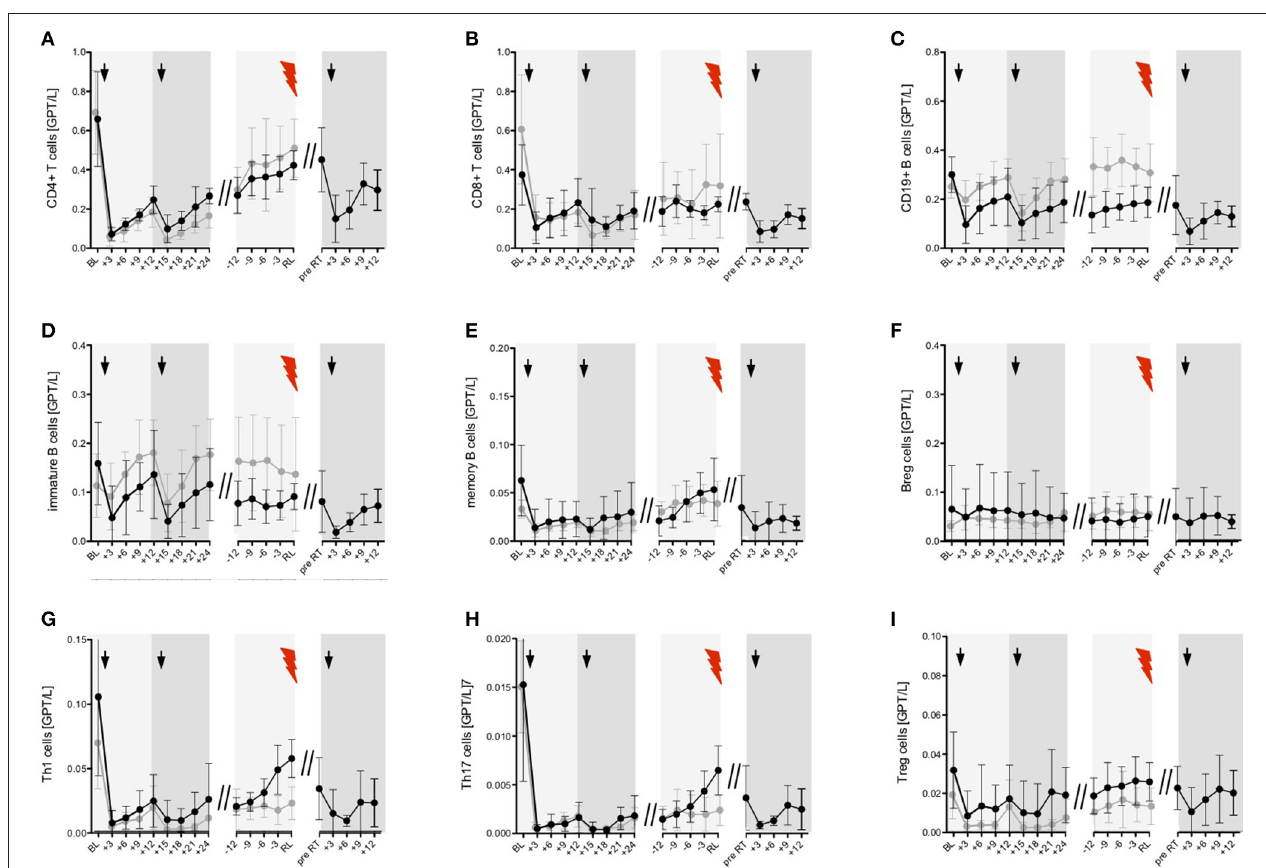
FIGURE 6 | Event-driven immune cell phenotyping before relapse activity and after ATZ retreatment. Distribution of absolute immune cell count of selected T (A,B, G–I) and B cell (C–F) subsets are presented. Black line—partial-responder patients: Immune cell subsets before (baseline, BL) and after 1st and 2nd ATZ infusion 3 monthly up to 24 months follow up ( + 3, + 6, + 9, + 12, + 15, + 18, + 21, + 24) are depicted. Mean values + / − 95%CI of all partial-responder patients are shown. Additionally, distribution of absolute immune cell count before clinical appearance of an acute relapse (RL, red flash) was evaluated in 3 monthly intervals ( − 12, − 9, − 6, − 3). Mean values + / − 95%CI of 13 relapses are presented. Furthermore, absolute immune cell count before ATZ retreatment (pre RT) and during 3 monthly follow up ( + 3, + 6, + 9, + 12) are demonstrated. Mean values + / − 95%CI of 10 ATZ retreatments are shown. Gray line—complete-responder patients: Immune cell subsets before (baseline, BL) and after 1st and 2nd ATZ infusion are depicted. In addition, period of stable disease course 24 months after 2nd ATZ infusion are presented. Mean values + / − 95%CI of all complete-responder patients are shown. Arrows indicate ATZ